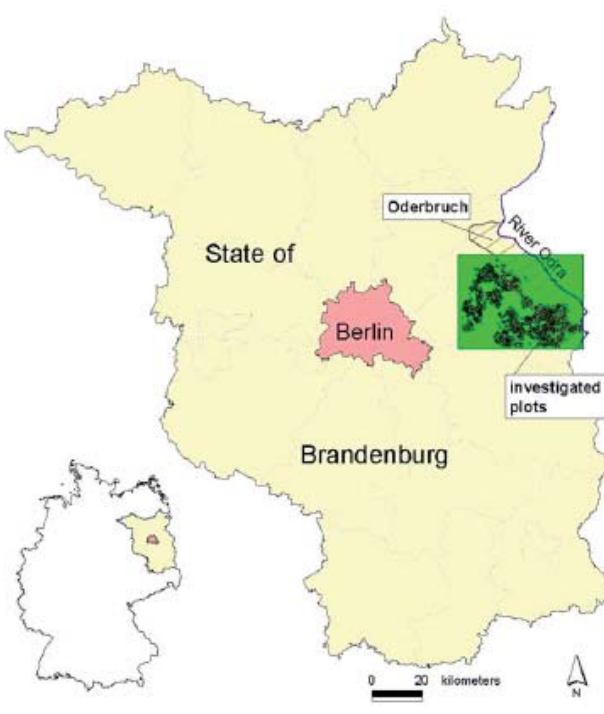
Figure 1. Research area (approx. 50 km east of Berlin). For a detailed presentation of the investigated plots see Figure